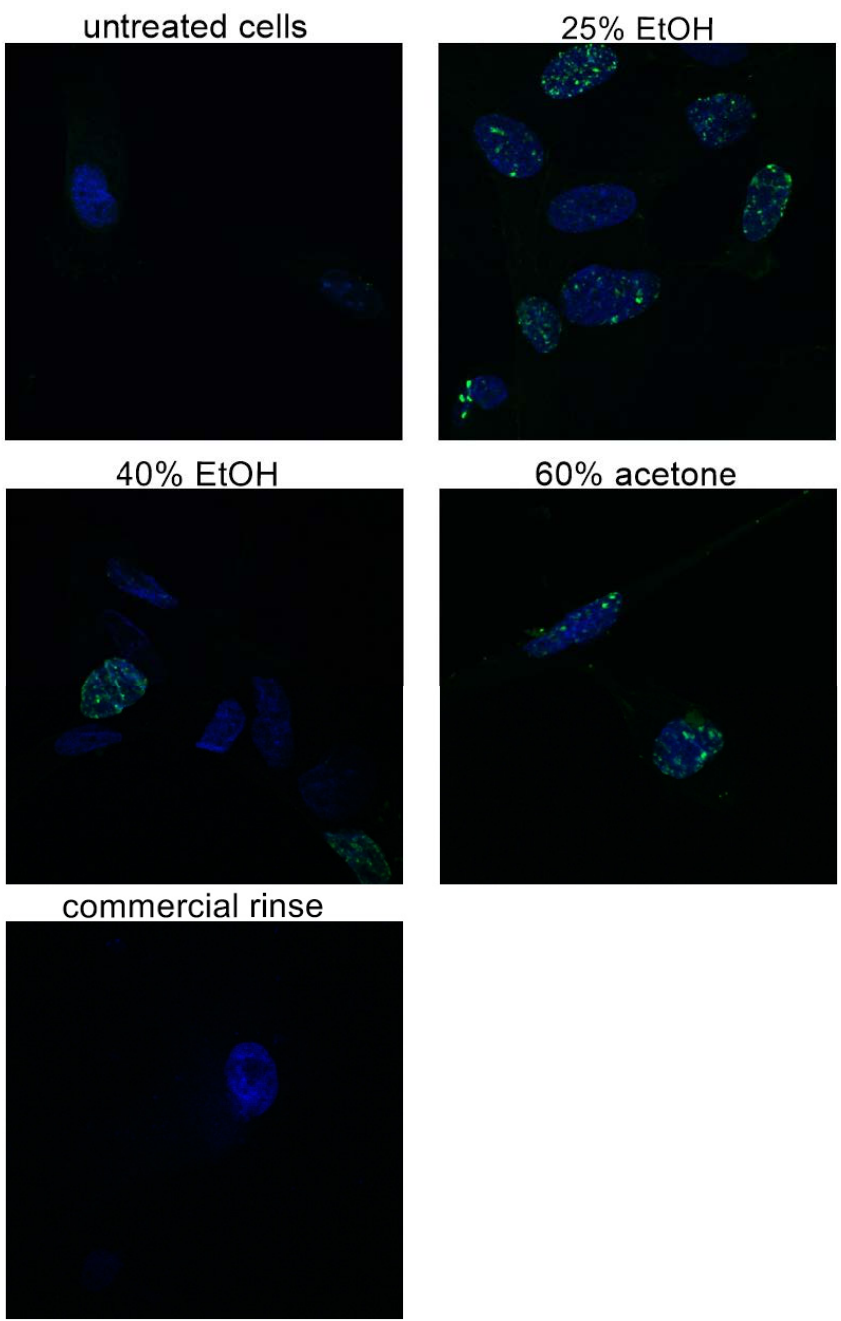
Figure 2. Microphotographs of fibroblasts with immunofluorescence staining histone H3 after 24 h incubation with different extracts of Reynoutria japonica (at the concentration of 50 µ g/mL) and commercial dental rinse (1.56% solution). Note that 25% EtOH, 40% EtOH, and 60% acetone means 25% ethanol extract, 40% ethanol extract, or 60% acetone extract from Reynoutria japonica rhizomes, respectively. Magnification on panel: × 600. Alexa Fluor 488 used for histone-3 labeled, DAPI used for the cell nucleus labeled.